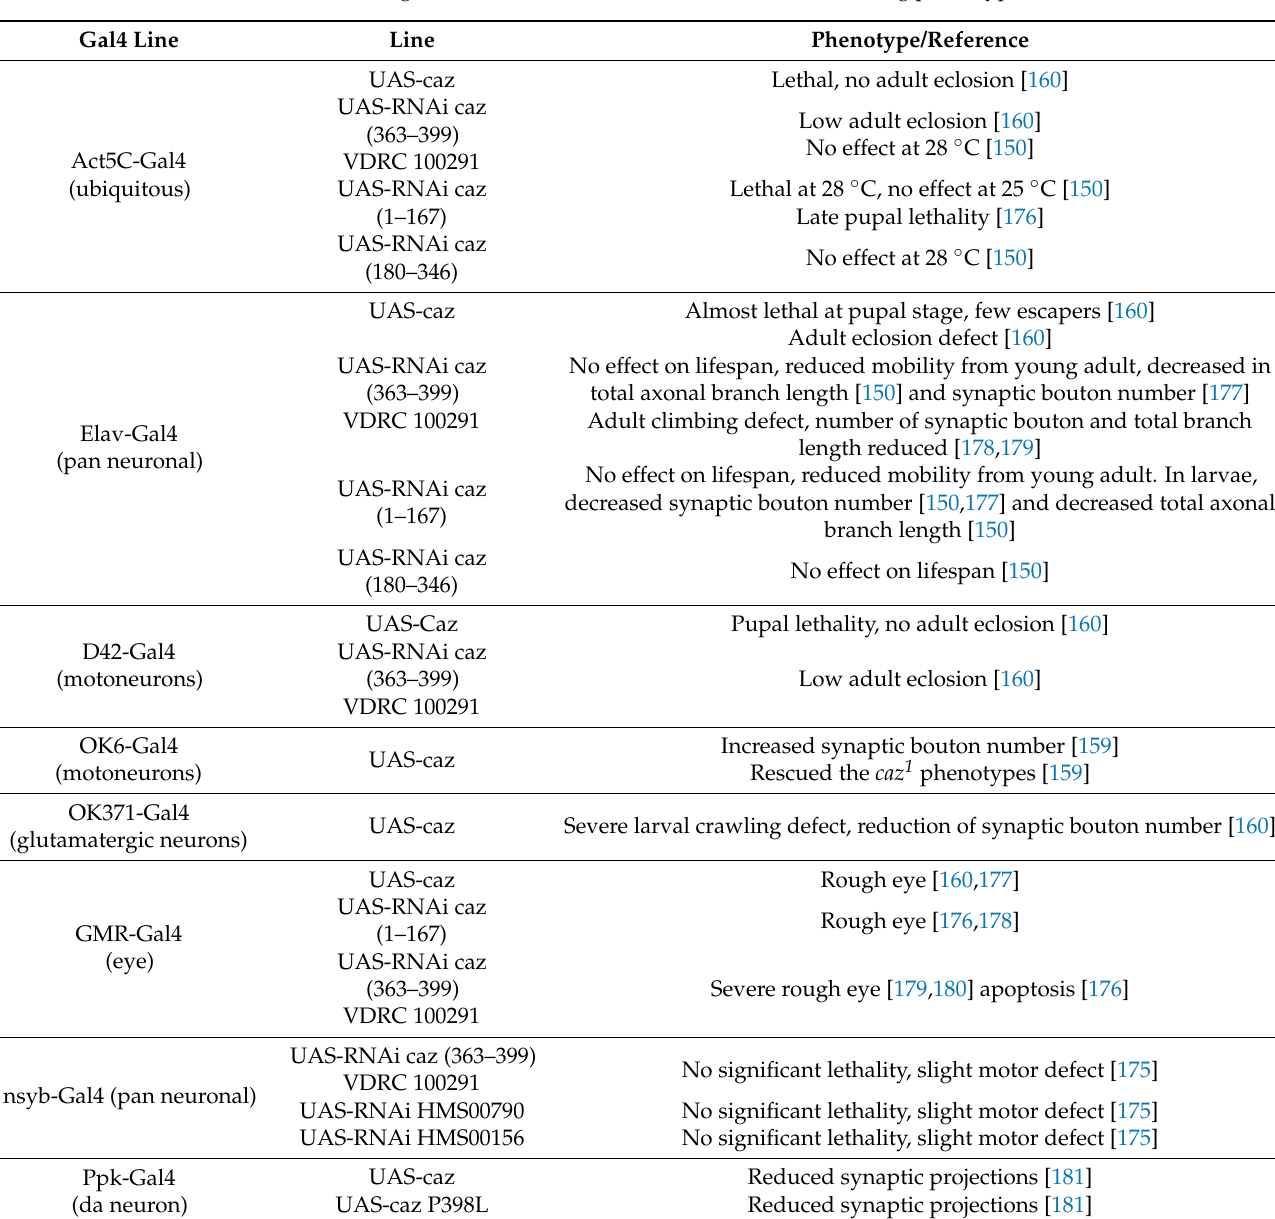
Table 5. Cabeza gain of function and RNAi-induced cabeza silencing